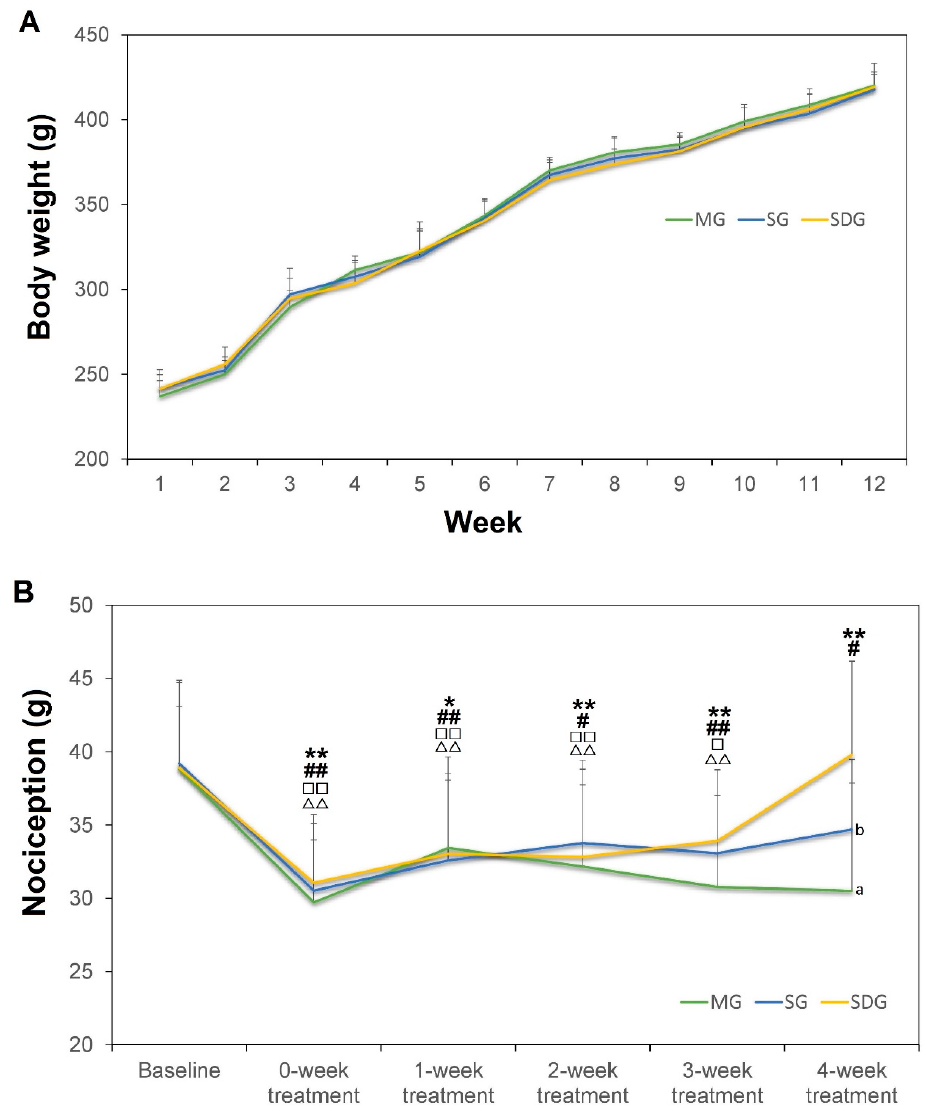
Figure 2. The body weight during the modeling period ( A ) and the nociception value during the treatment period ( B ), n = 12 for each group. Data are shown as mean ± SD. Compared to Baseline in MG group: ** p < 0.01, * p < 0.05; SG group: ## p < 0.01, # p < 0.05; SDG group: □□ p < 0.01, □ p < 0.05. Compared to 4-week treatment in SDG group: ∆∆ p < 0.01, ∆ p < 0.05. Compared to SDG group at the 4-week treatment: a p < 0.01, b p < 0.05 by Repeated Measures ANOVA with post hoc tests.